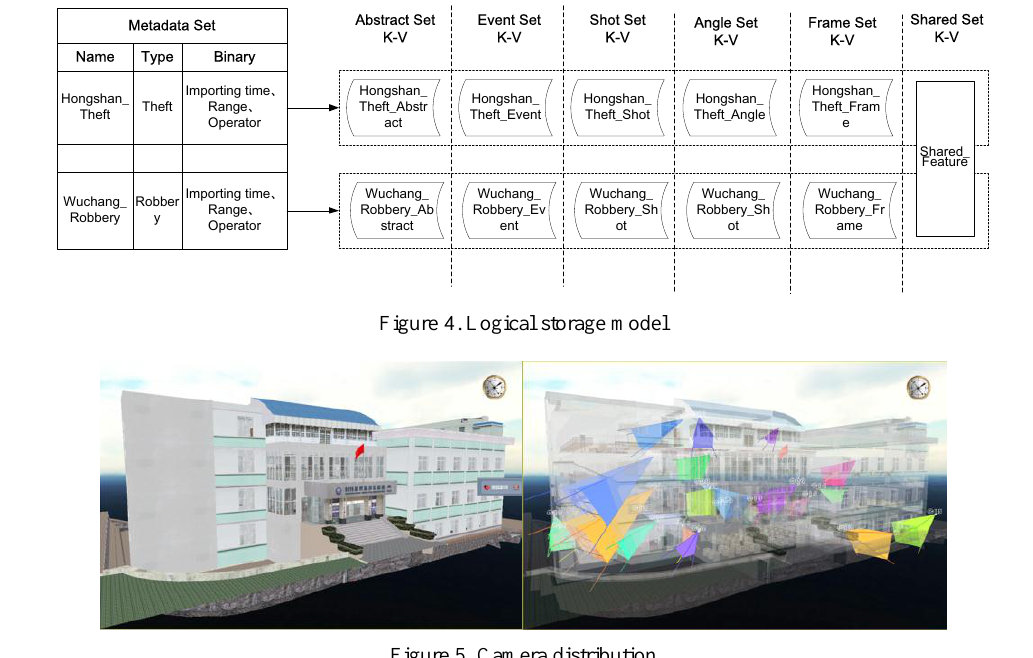
Figure 5. Camera